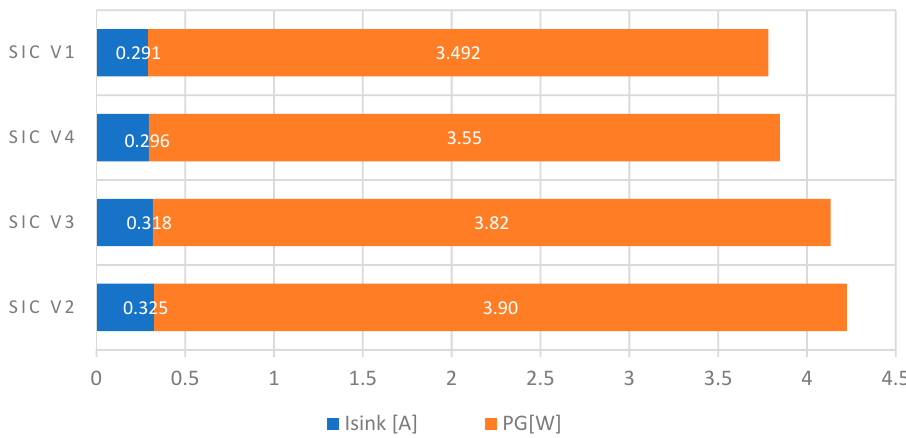
Figure 18. Requirements on the I sink and gate drive during turn-on transition at Vdc(link) = 400 Vdc, P OUT = 3 kW.